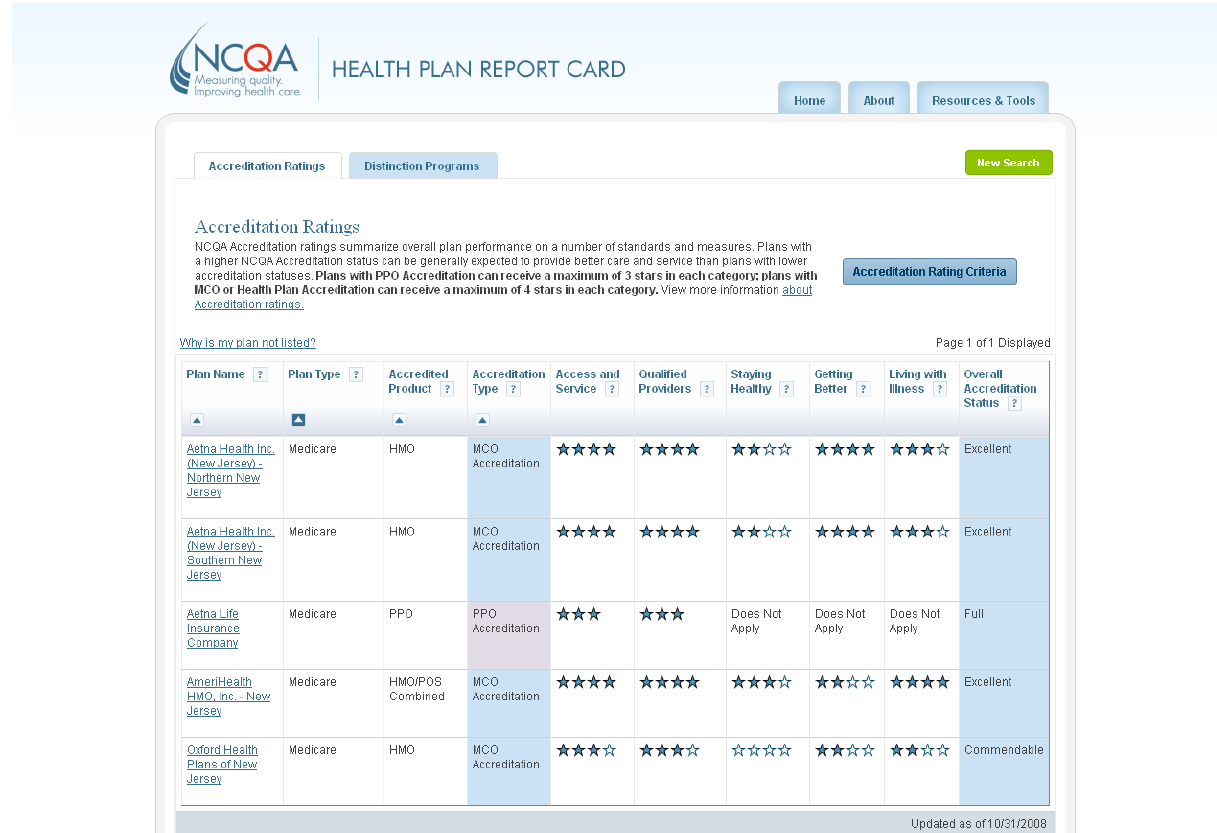
Figure 1. Example of a typical tabular format displaying providers in rows and attributes in